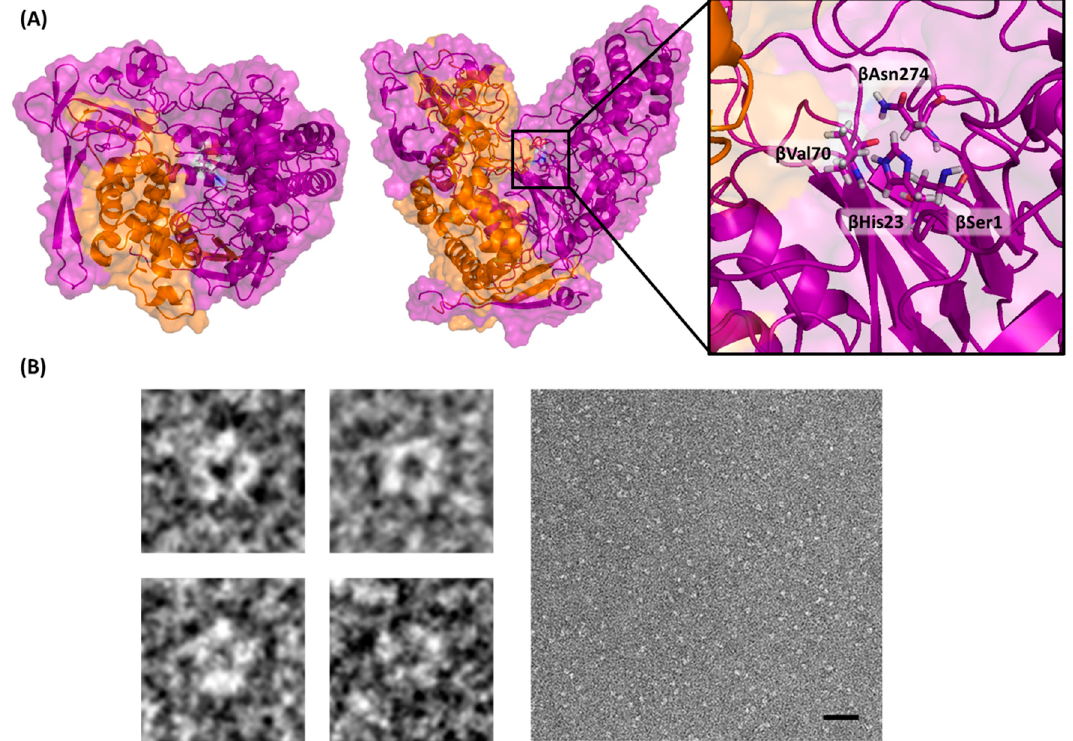
Figure 3. Tridimensional structure analysis of Au AHLA. ( A ) Predicted 3D heterodimeric structure model of Au AHLA, showing α -subunit in orange and β -subunit in purple. Top view, side view, and putative active-site catalytic amino acids ( β Ser1, β His23, β Val70, and β Asn274) are shown. ( B ) Electron microscopy micrographs of negatively stained Au AHLA. A nominal magnification of 50,000, scale bar 50 nm. Left, representative Au AHLA particles with an approximate diameter of 8 nm, and right, image of monodisperse and uniform Au AHLA sample.